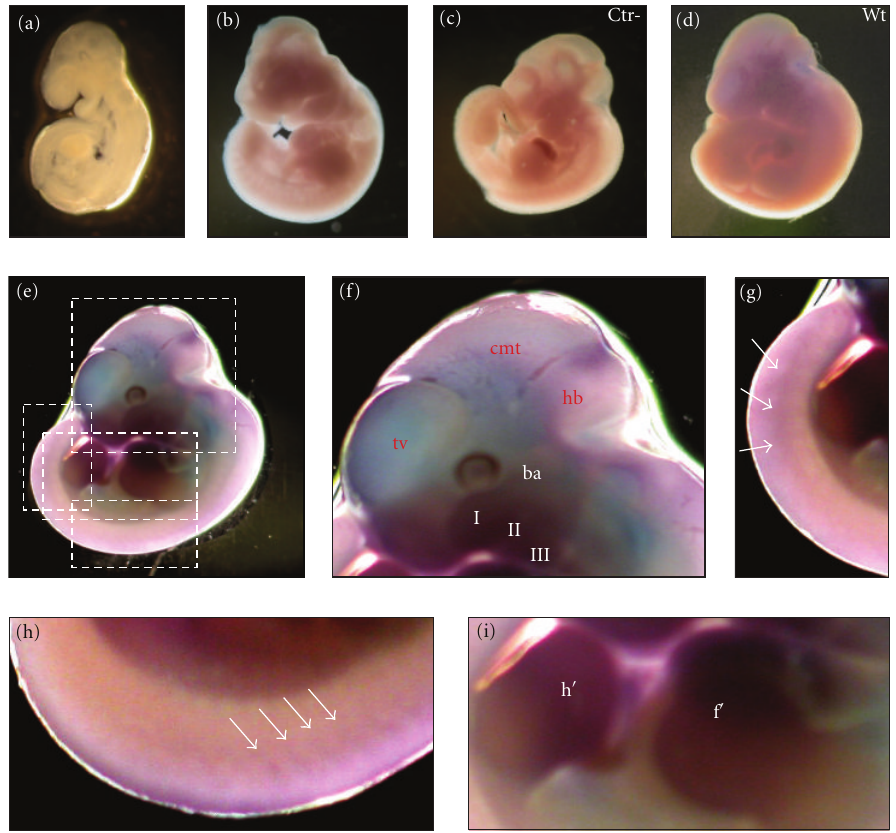
Figure 2: Expression of Magic-F1 in whole mount embryos. Lateral view of whole-mount in situ hybridization with digoxigenin labeled antisense Magic-F1 (a, b, d, e, f, g, h, and i) and sense Magic-F1 (c) cRNA probes as negative control (ctr-). Specific hybrids are visualized as a purple precipitate in all panels except in (a), 9.5 dpc and (b) 10.5 dpc. (e) Specific Magic-F1 transcripts are detected (f) in the mesodermal cells of the jaw and hyoid bone; in f, tv: telencephalic vesicles, cmt: mesenchymal cephalic tissue, hb: hindbrain, and ba: branchial arches where muscles are localized as well as around the eyes; a faint expression is also revealed in tail (g) and dorsal (h) somites, while a strong signal was selected in somites of fore (f (cid:2) ) and hind (h (cid:2) ) limb buds (i). In embryos hybridized with sense probe (c) background staining has not been detected as well as on 11.5 dpc wild type embryo (wt) hybridized with antisense probes